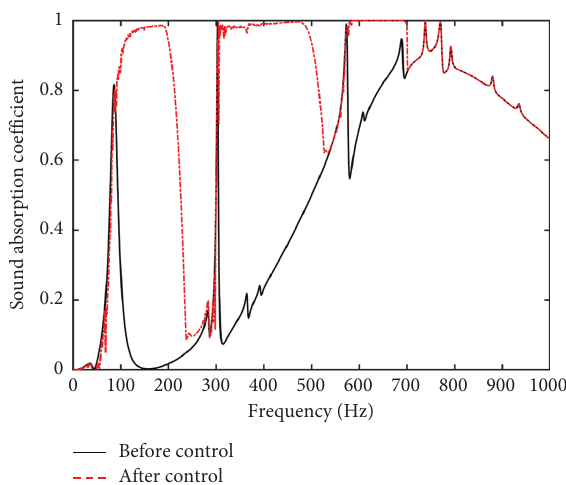
Figure 4: Sound absorption coefficient of the active MPPA before and after control.